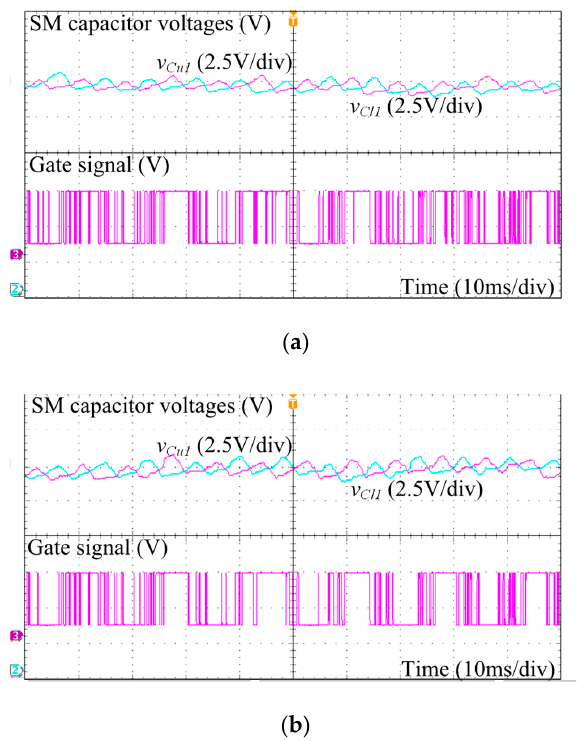
Figure 15. SM capacitor voltages and gate signal of one power device: ( a ) without switching loss balancing control; ( b ) with switching loss balancing control.